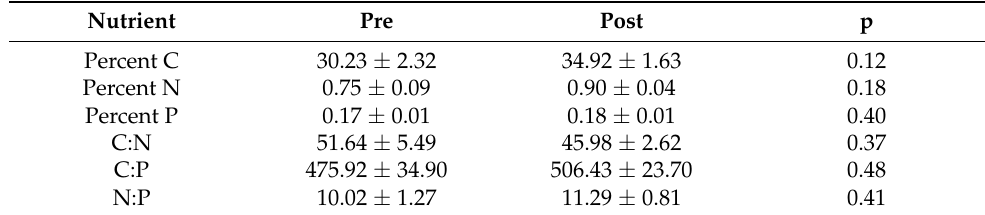
Table 2. Percent nutrient concentrations and molar ratios ( µ ± se) of belowground vegetation for pre- and post-experimental sampling